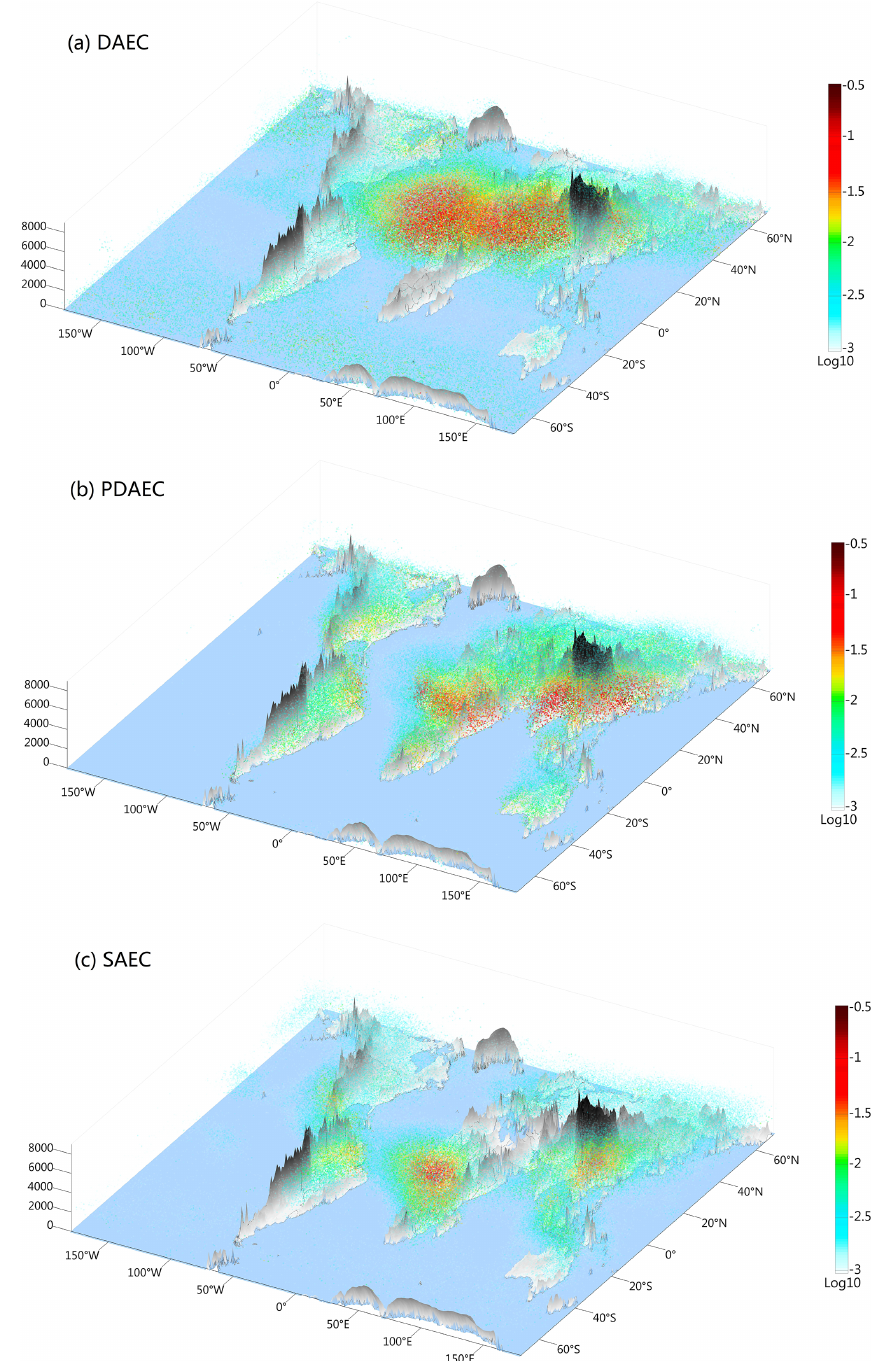
Figure 2. As in Fig. 1 but for type-dependent aerosols: (a) dust; (b) polluted dust (PD); and (c)